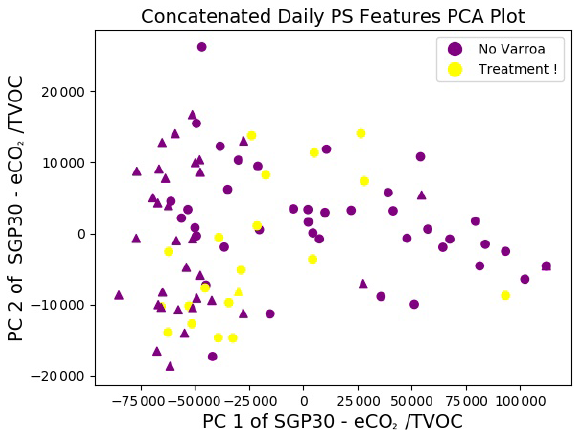
Figure 11. Scatterplot of the first and second principal components of the SGP30 eCO 2 and TVOC outputs for cross classification of the July–September (circles) and additional May–June (triangles) campaigns with two classes of VILE.